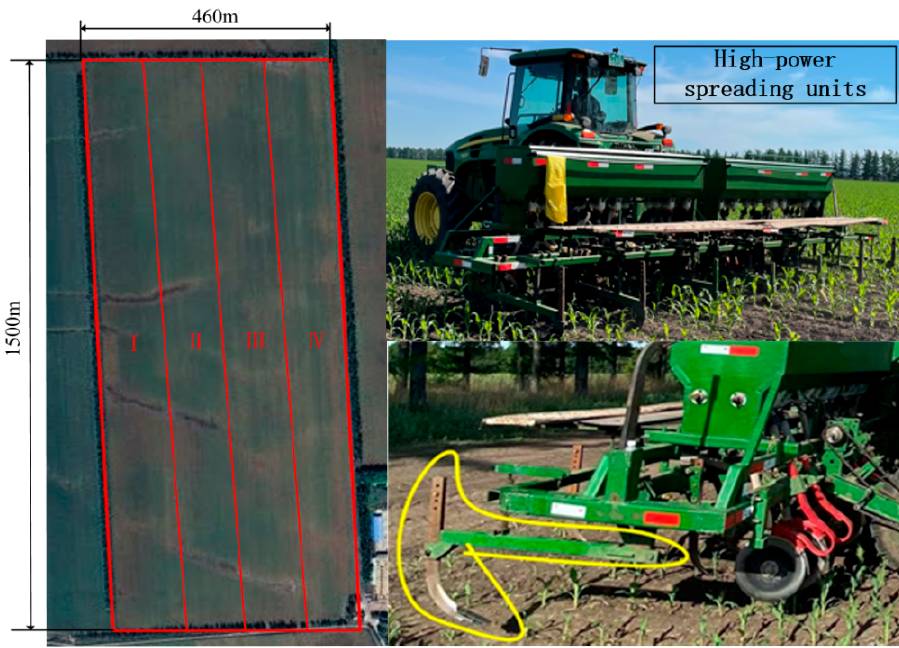
Table 1. Seeding unit parameters .